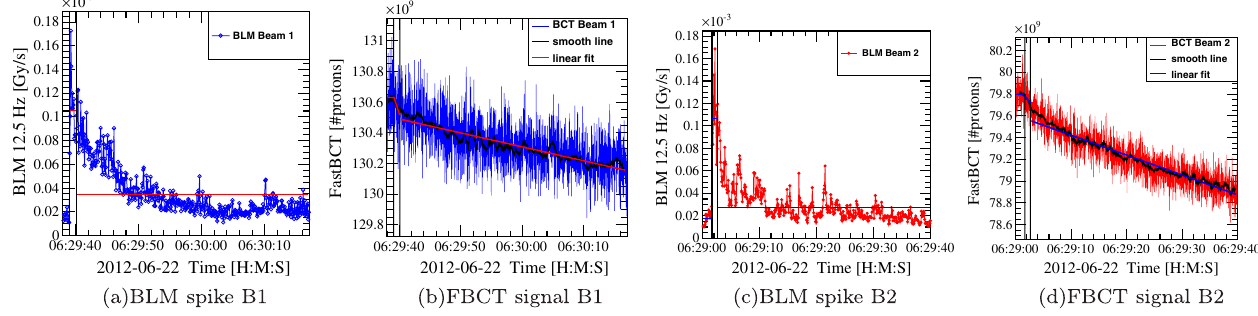
FIG. 7. Examples of fits made to the BLM and FBCT signals during loss spikes following a B1 [parts (a) and (b)] and B2 [parts (c) and (d)] collimator jaw movement, respectively. The dose in Gy is calculated by integrating the BLM signal over (cid:6) 1 s and the intensity lost in the same period is determined to calculate the calibration factor for each loss spike.